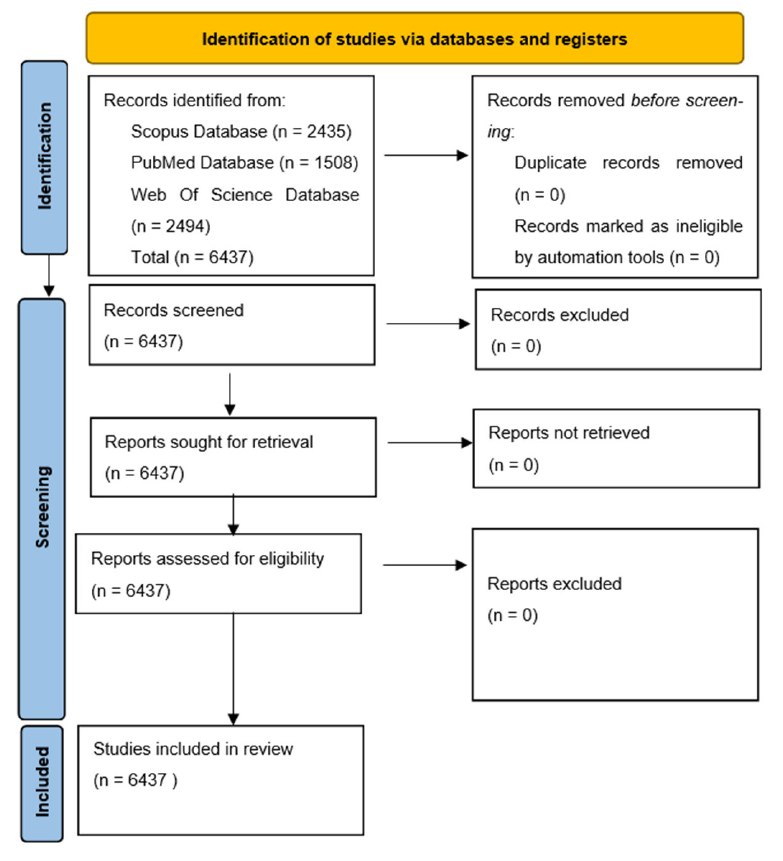
Figure 1. PRISMA Chart. [15].